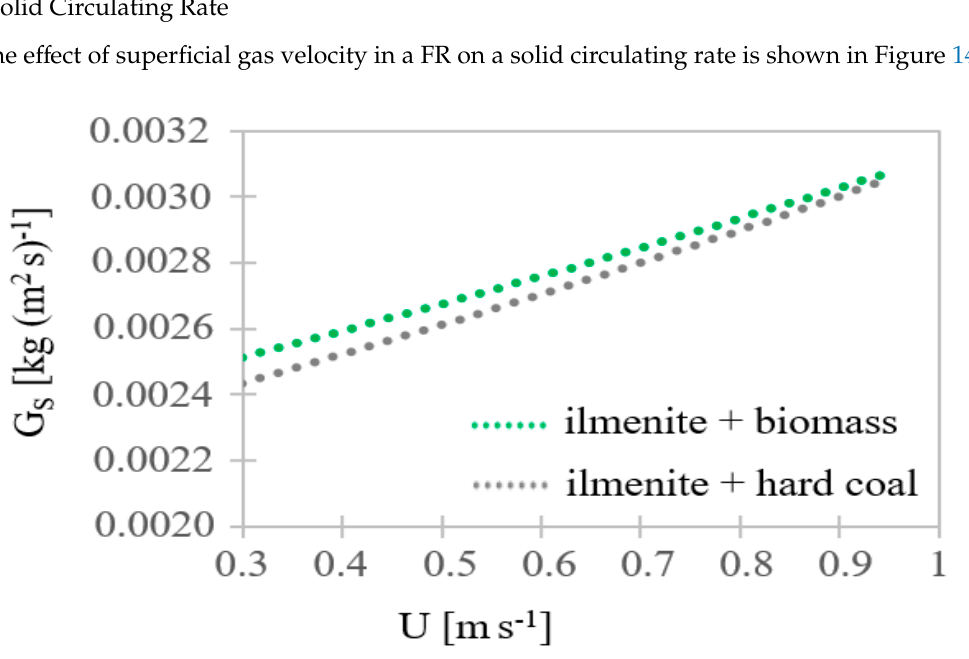
Figure 14. The solid circulating rates of the ilmenite versus superficial gas velocity in the FR.